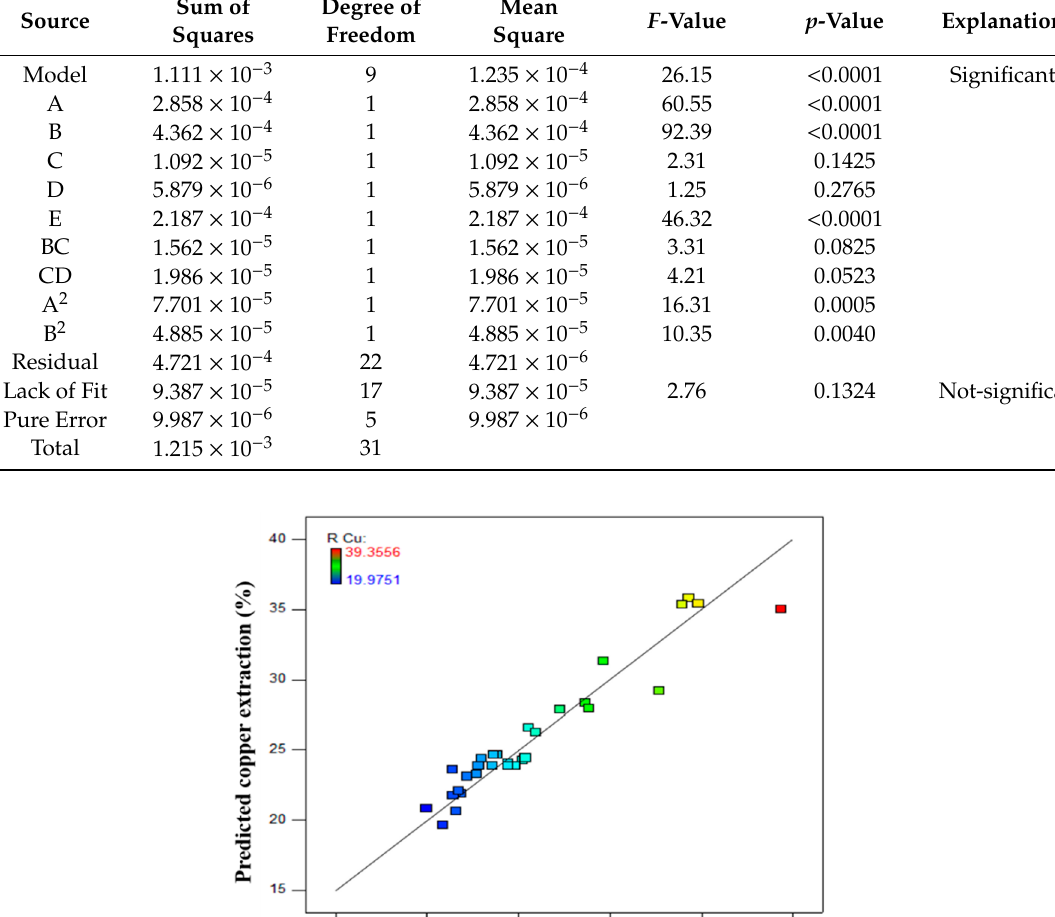
Table 6. Analysis of variance for copper recovery.